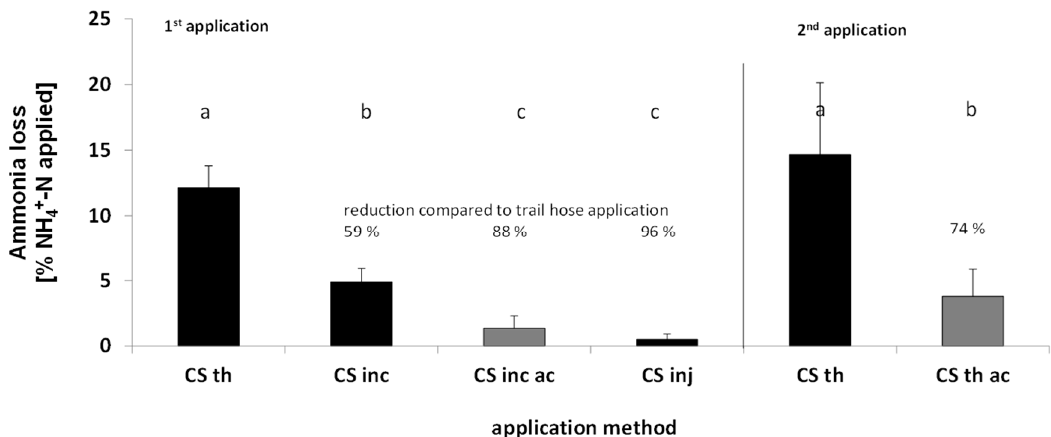
Figure 2. Cumulative NH3 losses after application of cattle slurry to spring barley, application rates 84.8 kg TAN ha − 1 (1st trial), 84.8 kg N ha − 1 . Lowercase letters indicate significant differences between treatments at p < 0.05 ( n = 4 except n = 2 for CS th 1st trial; mixed effects model, HSS test p < 0.05; lowercase letters indicate significant differences between treatments; CS, cattle slurry; th, trail hoses; inc, harrow incorporation; inj, closed slot injection; ac, acidification) .